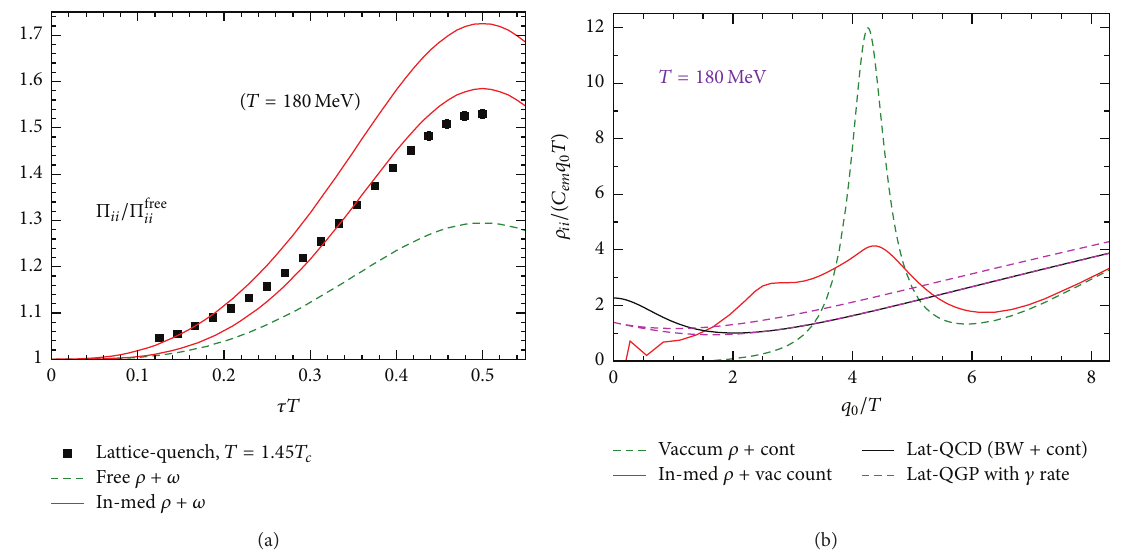
Figure 3: (a) Euclidean correlators of the EM current as computed in quenched thermal lQCD (data points) [14], compared to results from integrating hadronic spectral functions using (5) without (dashed green line) and with in-medium effects (red lines, with free and in-medium continuum threshold) [37]. (b) Vector-isovector spectral functions at 𝑞 = 0 corresponding to the Euclidean correlators in (a) in vacuum (green dashed line), in hadronic matter calculated from many-body theory at 𝑇 = 180 MeV [13] (red solid line), and in a gluon plasma at 1.4𝑇 𝑐 extracted from thermal lattice-QCD (black solid line) [14]; the 3-momentum extended lQCD rates according to (8) are shown for (short-dashed lines, with (lower) and without (upper) form factor